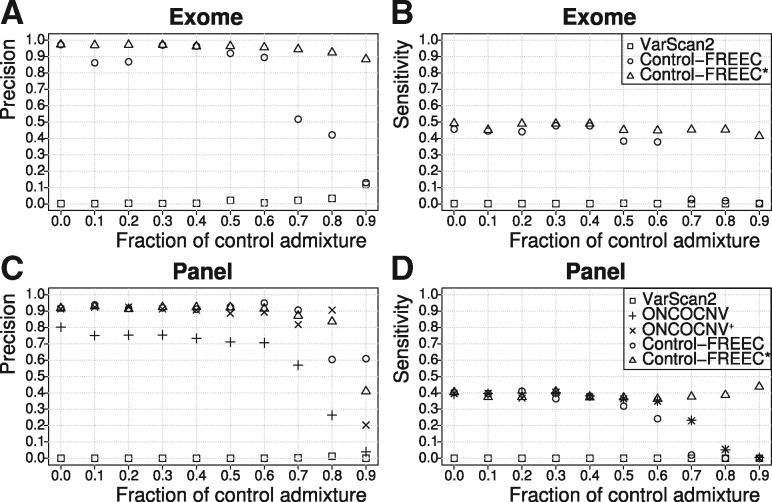
Average precision and sensitivity of SCNA callers on simulated tumors with different levels of tumor impurity. (A, B) Exome and (C, D) targeted gene panel data. Each data point represents the average of five experiments. *Control-FREEC with anticipated admixture level set as parameter; +ONCOCNV with additional pooled control samples